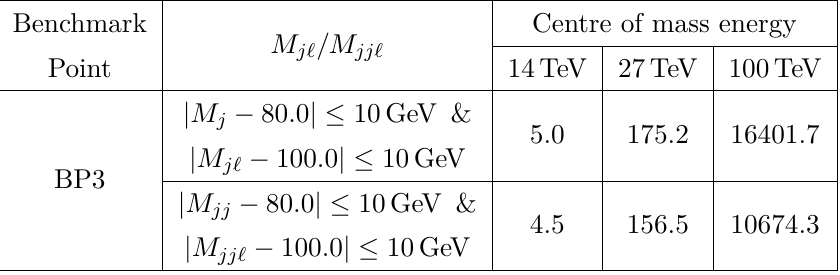
Table 5. The number of events in M j‘ and M jj‘ distributions after the window cut around the mass peak for BP3 with the centre of mass energies of 14 TeV, 27 TeV, 100 TeV at the integrated luminosities of ( L = ) 3, 10 and 30 ab − 1 , respectively. An additional window cut of 10 GeV around int the W ± mass peak is also implemented while reconstruction of RHN